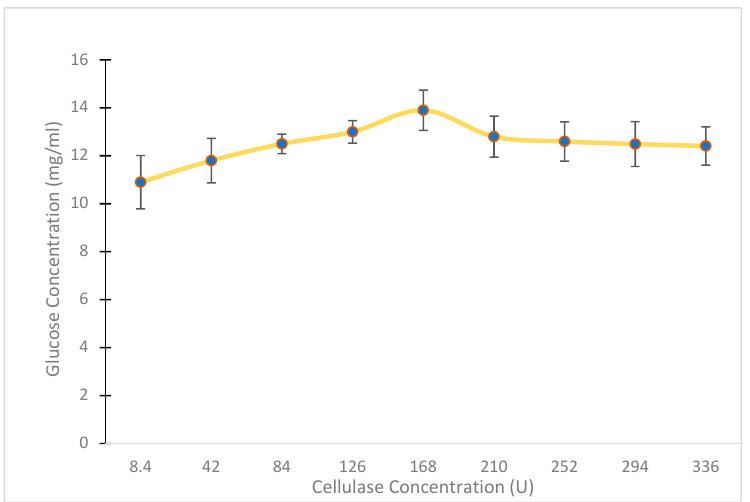
Figure 5. Determination of the optimum chemical/physical and enzymatic concentrations that resulted in the highest production of glucose from cellulosic fiber waste.